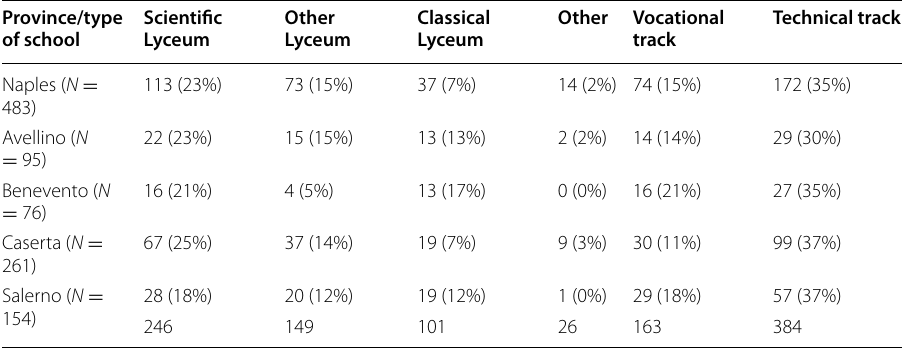
Table 5 All the 1069 schools in the Campania region included in Model 1, grouped by province and type. The percentages are relative to the